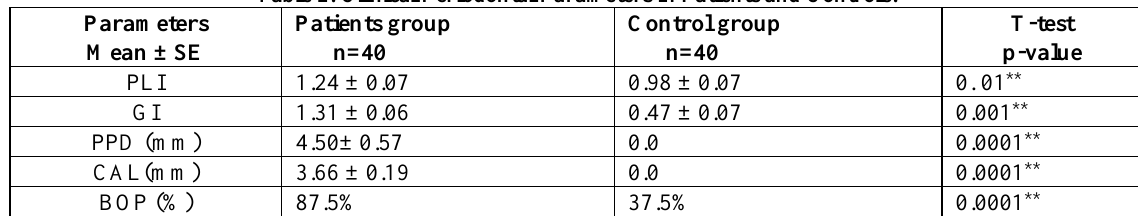
Table 2: Clinical Periodontal Parameters in Patients and